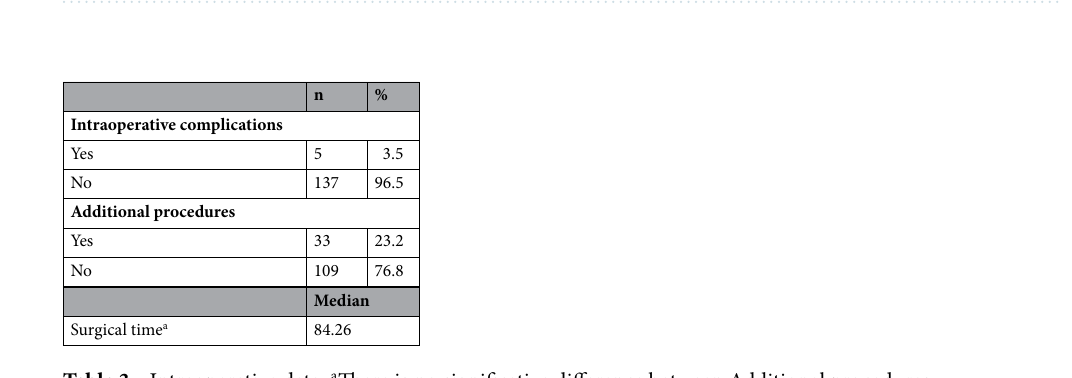
Table 3. Intraoperative data. a There is no significative difference between Additional